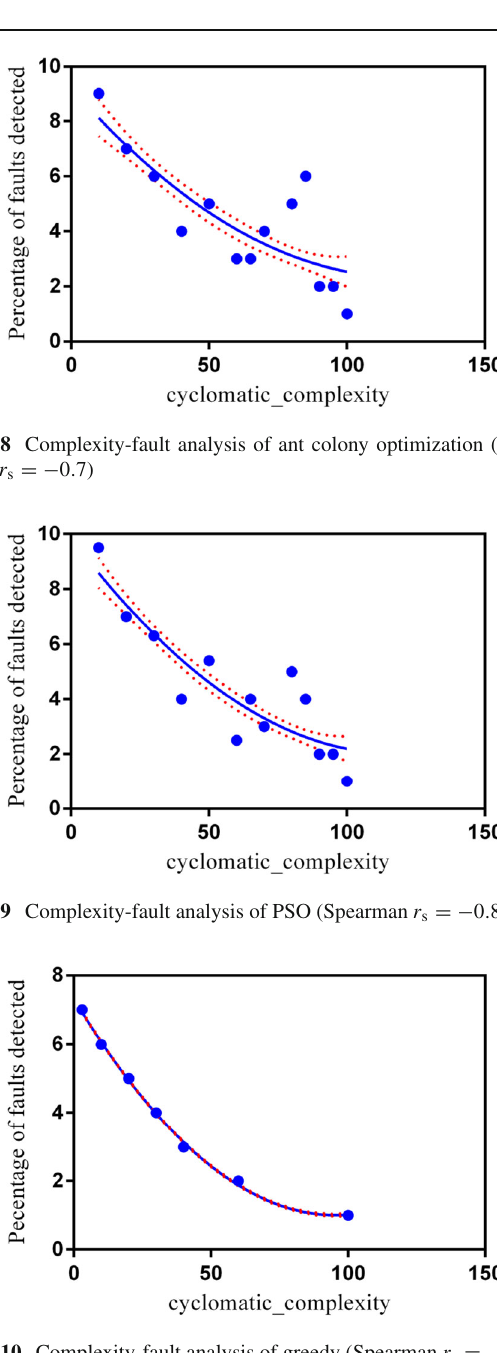
Fig. 10 Complexity-fault analysis of greedy (Spearman r s = − 0 .